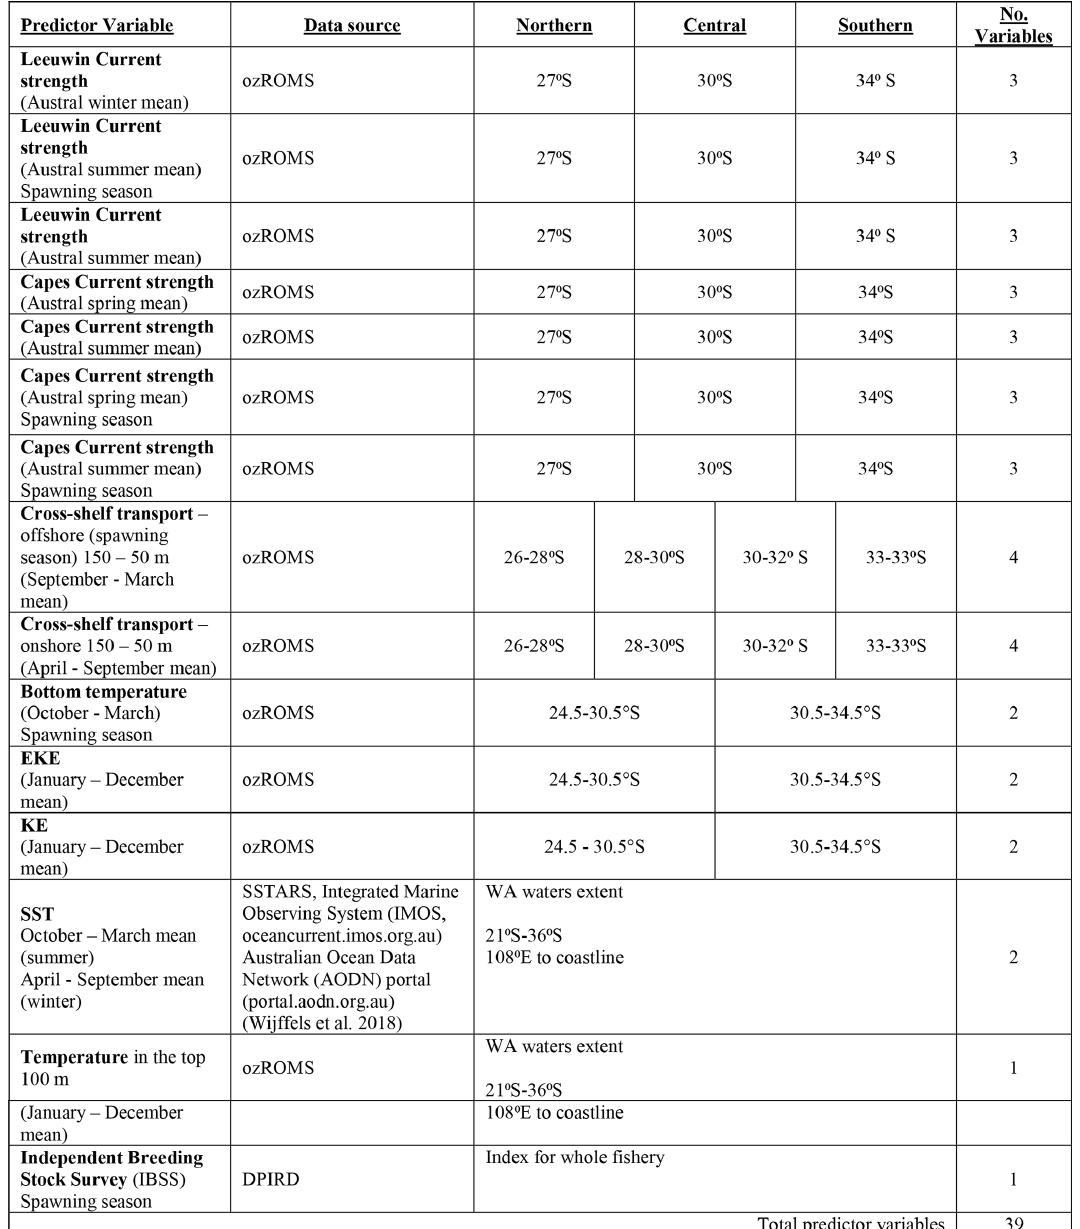
Table A1. Oceanographic data sources and sites used to calculate the 40 predictor variables included in time series analysis. Unless stated, the timing is within the season of puerulus settlement. Spawning season indicates that the variable is from the year prior or within the spawning season as larvae